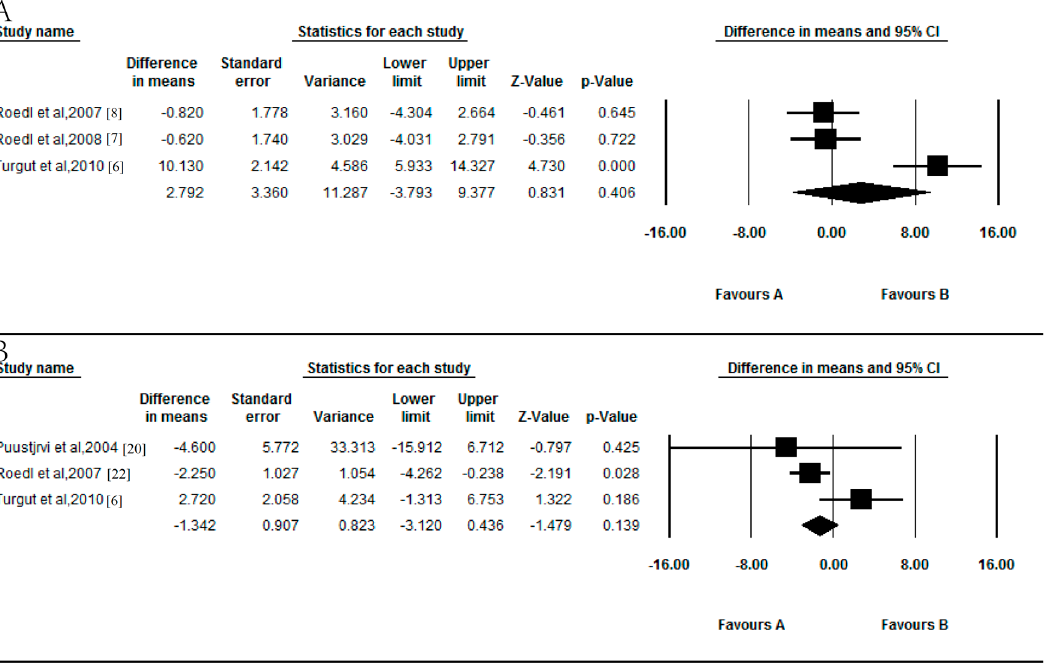
Figure 2. Forest plot of random effects meta-analysis showing the association of serum vitamin B 6 levels with POAG ( A ) and EXG ( B